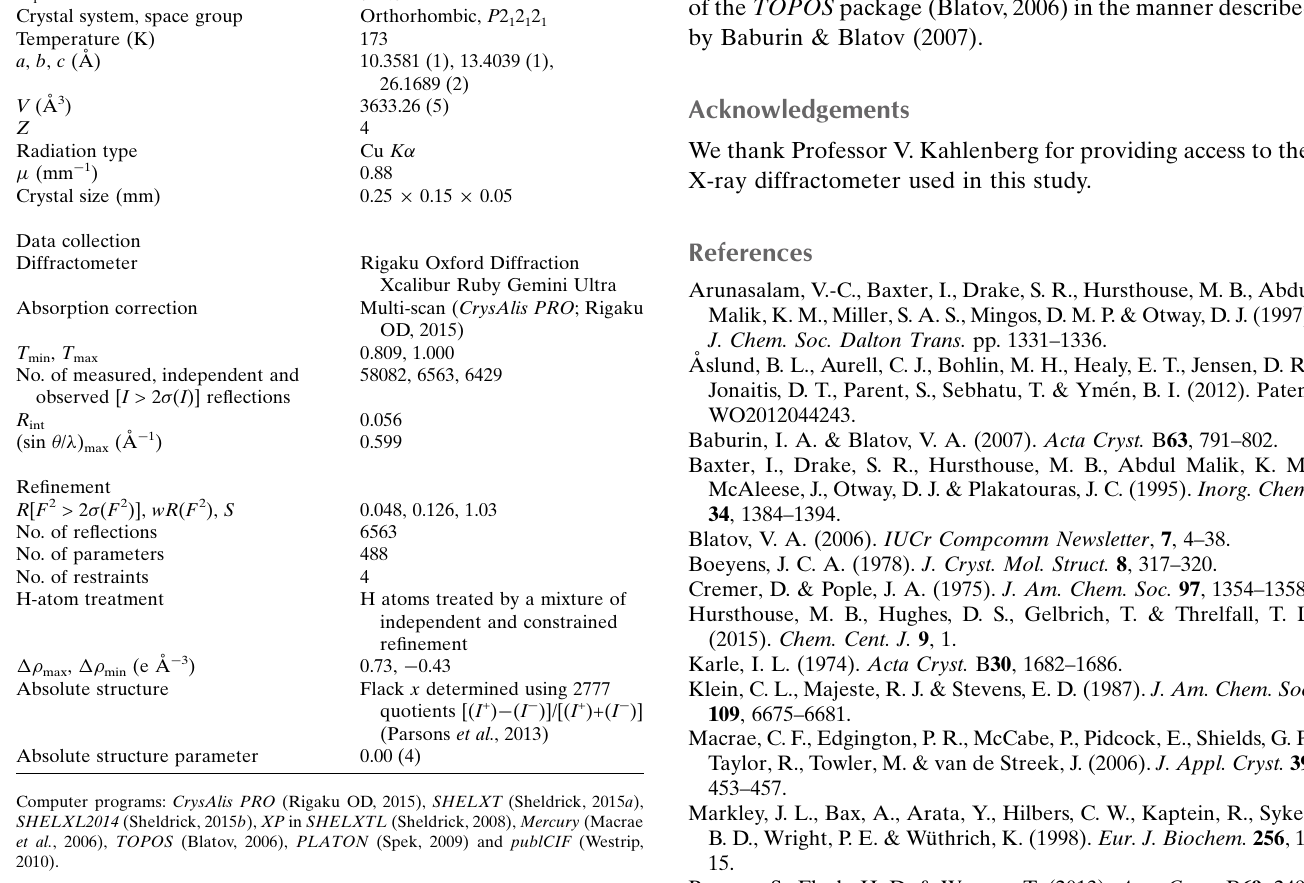
Table 3 Experimental details. Crystal data Chemical